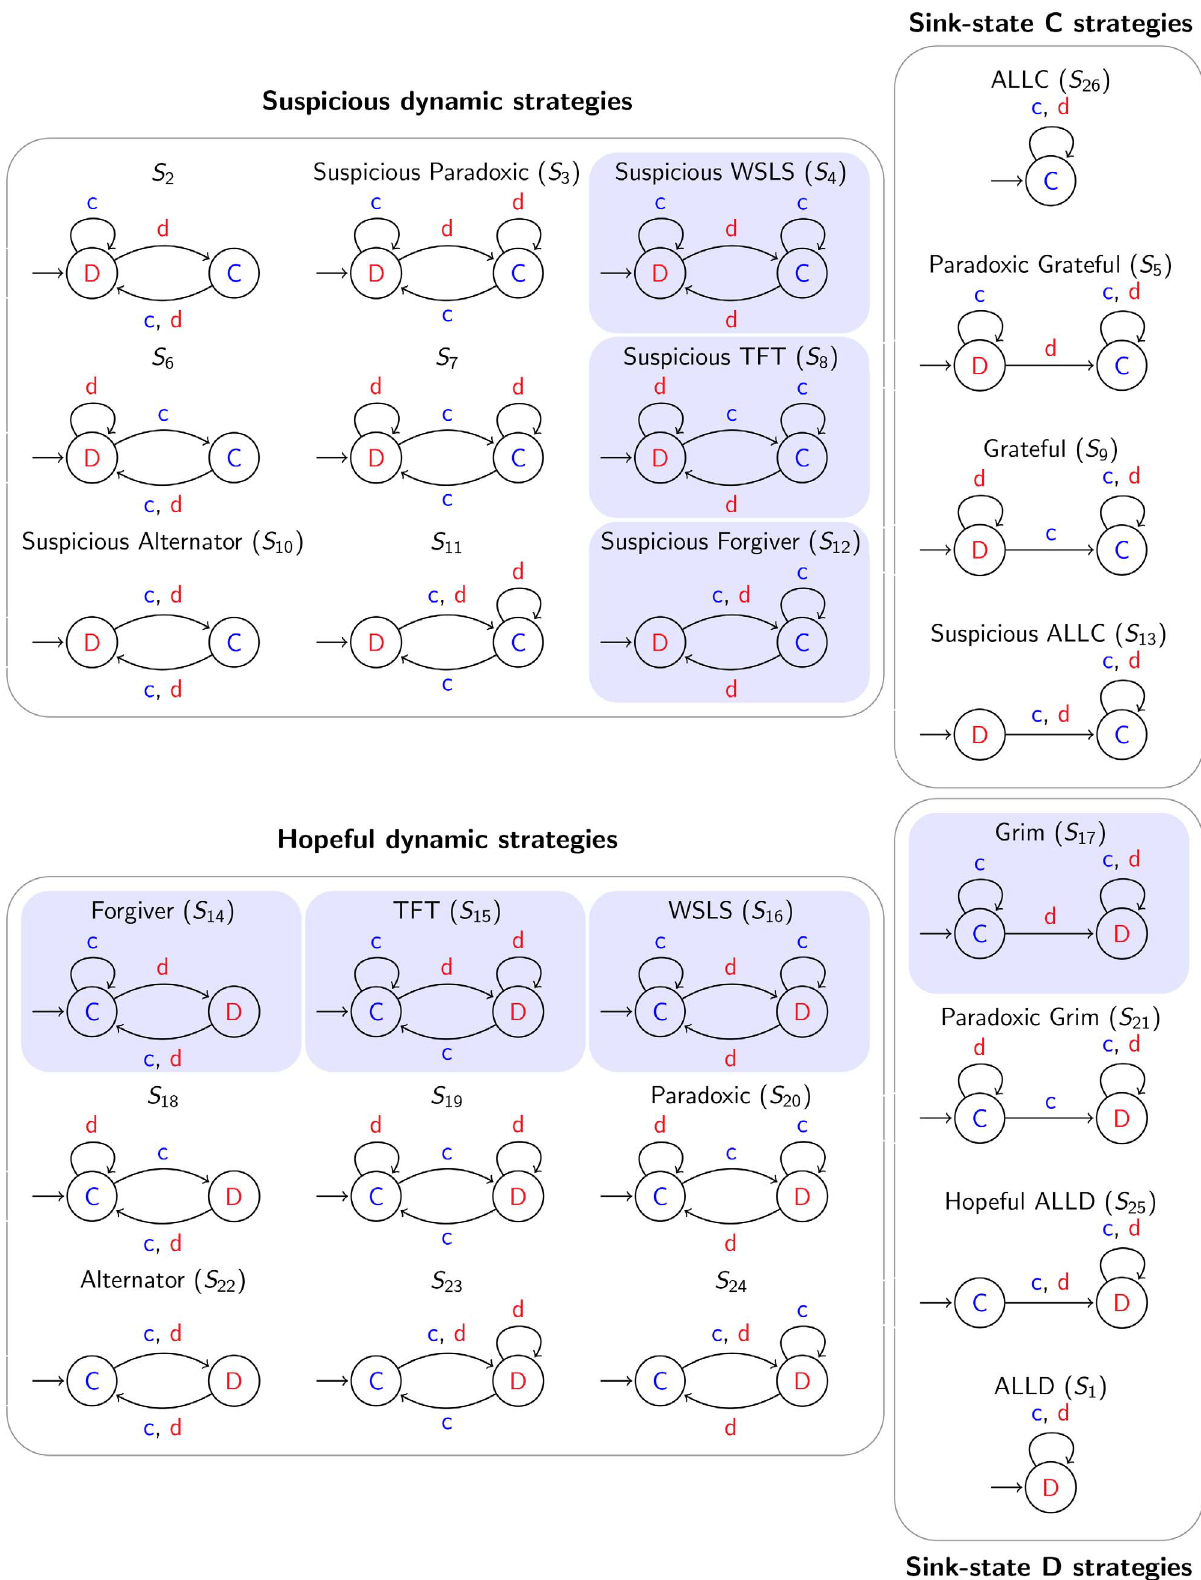
Figure 1. Deterministic strategies in the Prisoner’s Dilemma. Each automaton defines a different strategy for how a player behaves during the game. If a player is in state C , she will cooperate in the next move; if she is in state D , then she will defect. The outgoing transitions of a state define how the state of an automaton will change in response to cooperating (label c) or defecting (label d) of the opponent. The left state with the